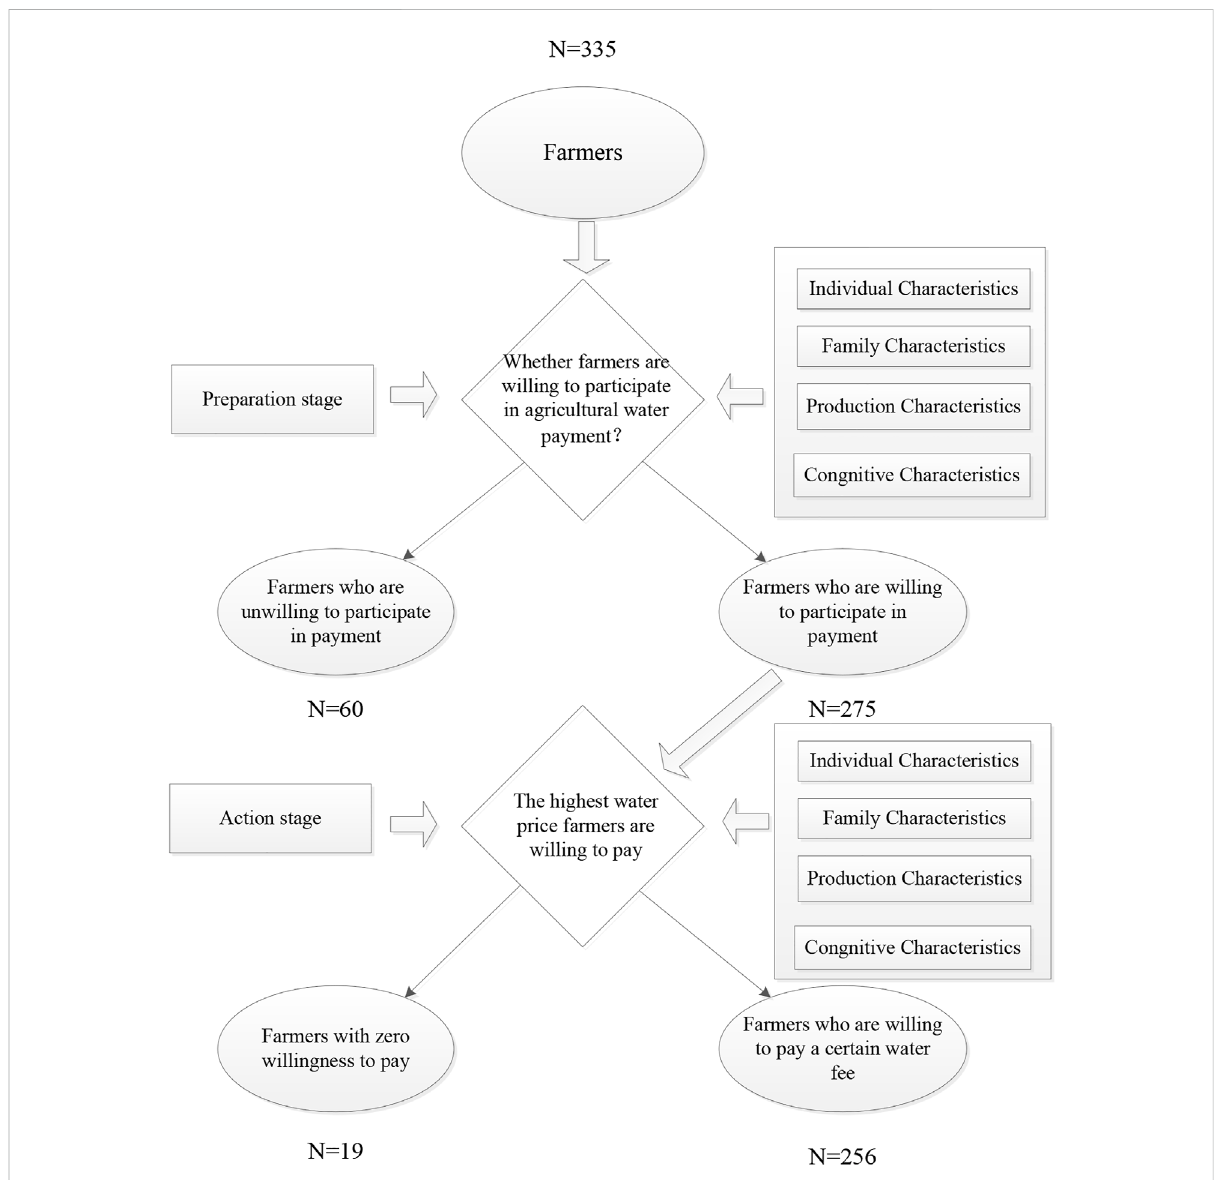
FIGURE 2 Two-stagebehavioroffarmersparticipatinginagriculturalwaterfeepayments. “ N ” wasaddedheretorepresentthenumberofsamplesineach stage of the